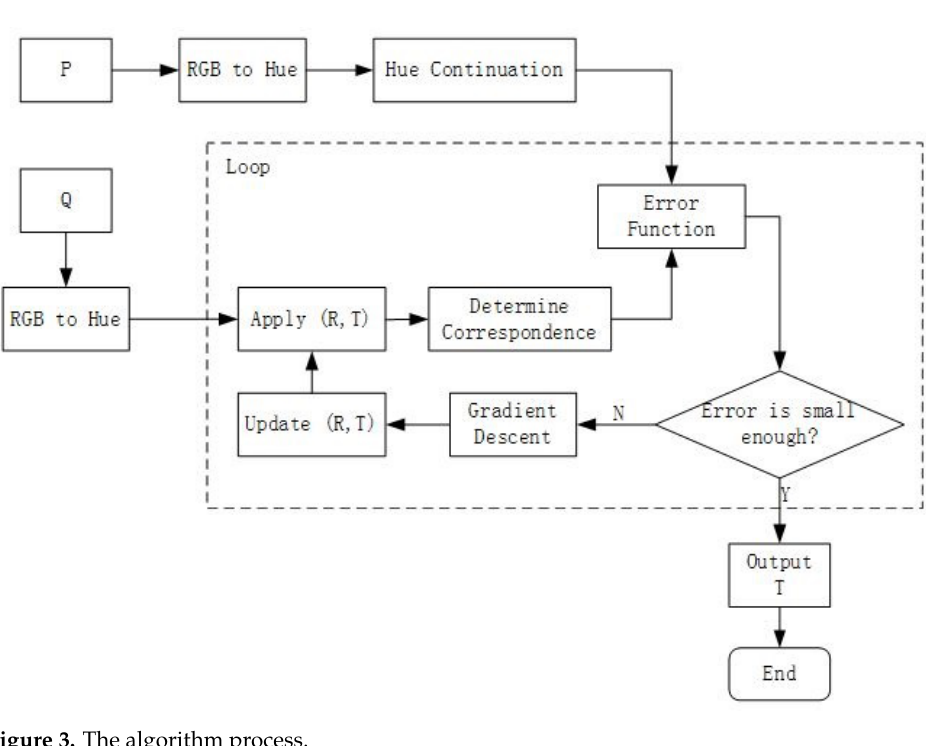
Figure 3. The algorithm